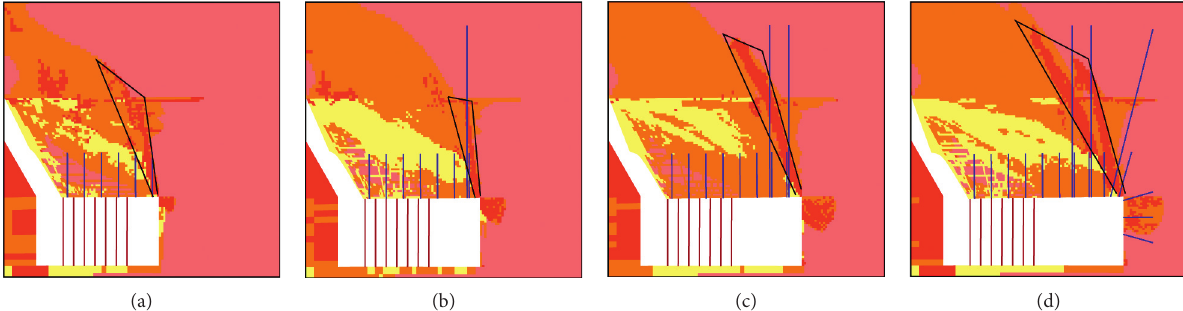
Figure 12: Distribution of failure zone during formation process of removal area. (a) First cutting. (b) Second cutting. (c) Third cutting. (d) Final